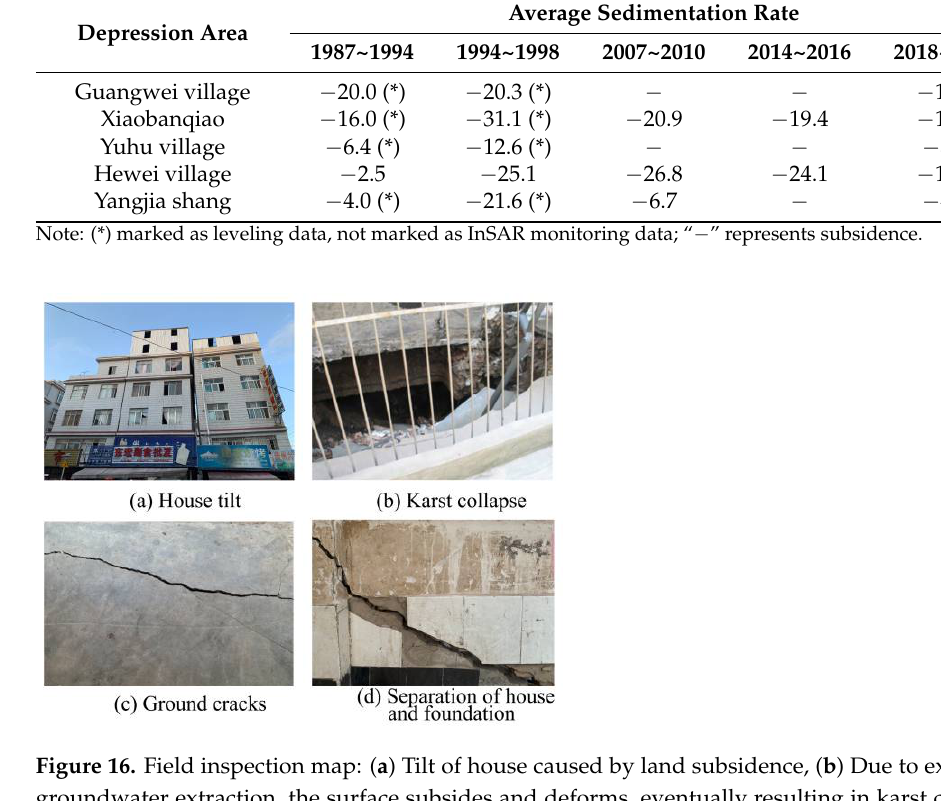
Table 8. Subsidence rates of the study area at different times.